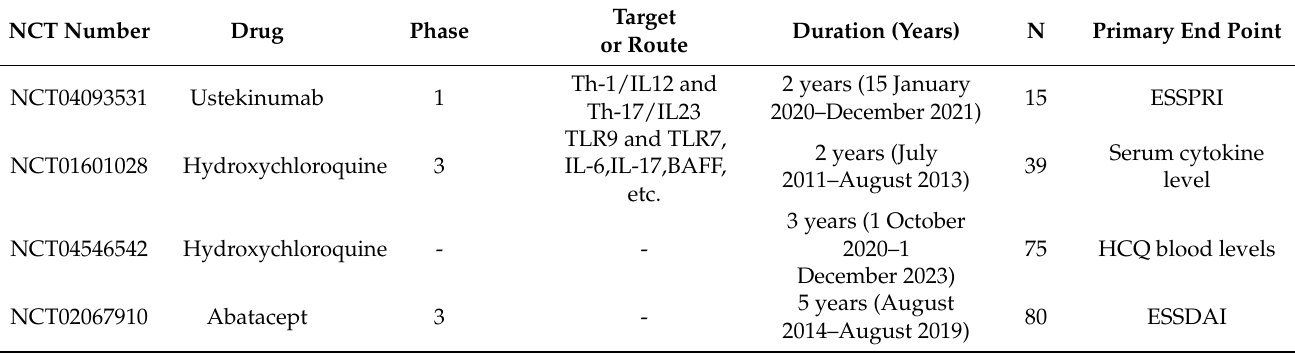
Table A2. Clinical trials in pSS from 2000 to